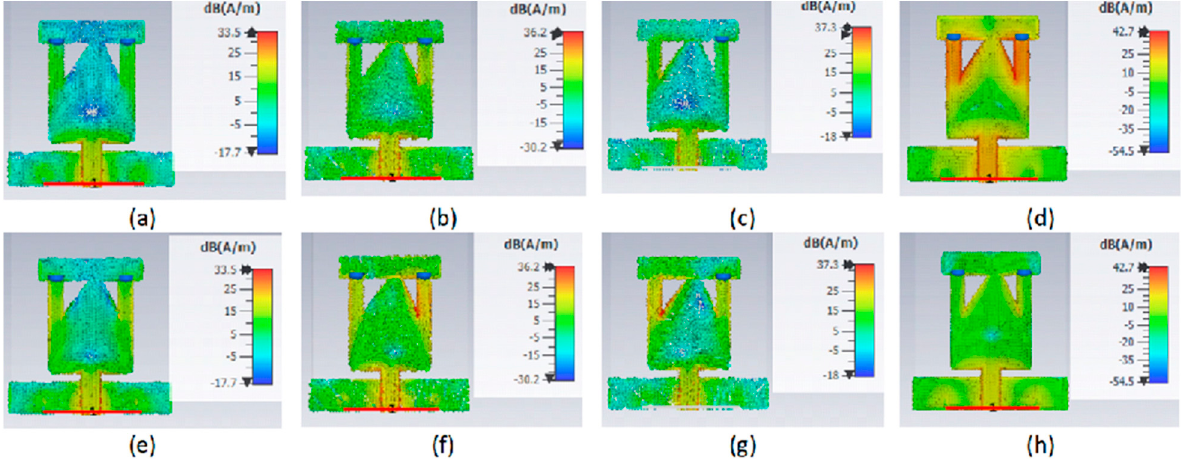
Figure 12. Surface current at 3.5 GHz: ( a ) D1(ON) and D2(ON); ( b ) D1(OFF) and D2(ON); ( c ) D1(ON) and D2(OFF); ( d ) D1(OFF) and D2(OFF) & at 4 GHz; ( e ) D1(ON) and D2(ON); ( f ) D1(OFF) and D2(ON); ( g ) D1(ON) and D2(OFF); ( h ) D1(OFF) and D2(OFF).